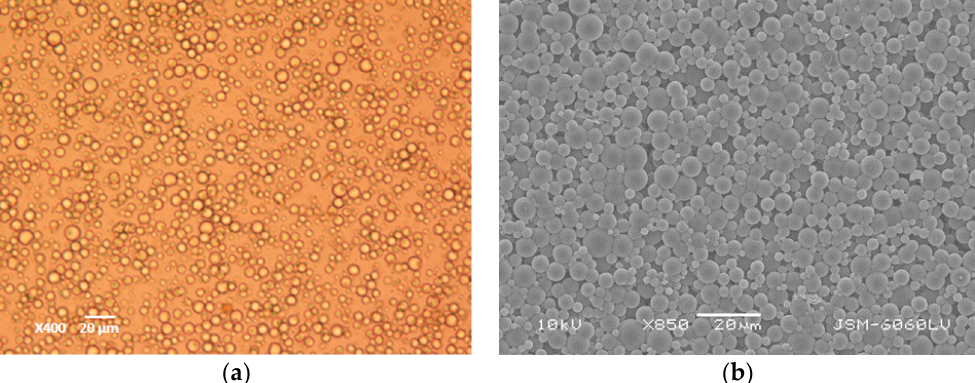
Figure 5. Citronella oil microcapsules produced with in situ polymerization: ( a ) aqueous suspension of microcapsules at end of polymerization process (TLM, 400×); ( b ) SEM of dry microcapsules (850×). Coatings 2019 , 9 , 470 Table 6. Properties of microcapsules produced with in situ polymerization.